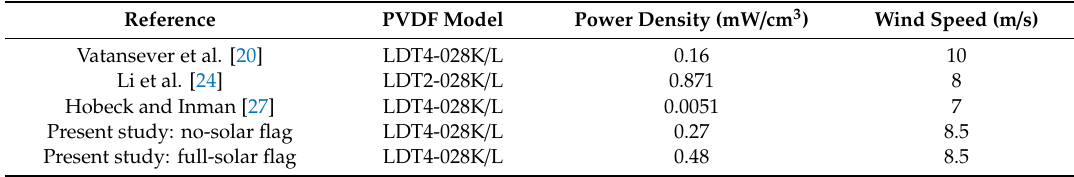
Power density comparison of di ff erent harvesters based on polyvinylidene fluoride (PVDF)